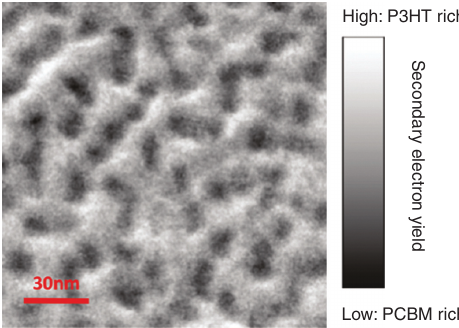
Figure 9 HIM imaging of BHJ solar cell active layer constituted with P3HT electron donor and PCBM electron